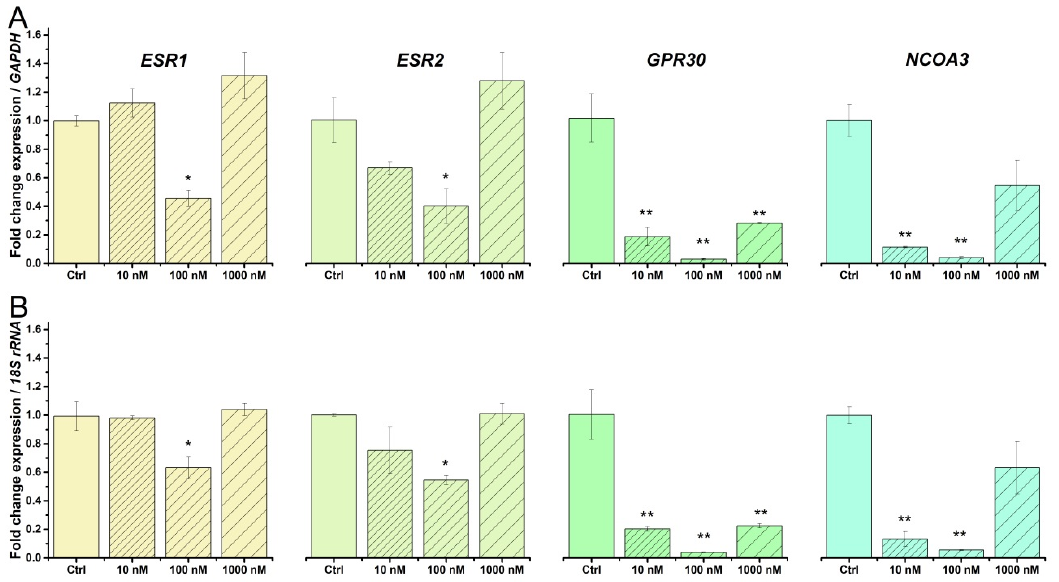
Figure 4. Effect of beta ‐ estradiol treatment (10, 100, and 1000 nM) on the mRNA levels encoding the estrogen receptors and nuclear receptor co ‐ activator in human myometrial TCs from pregnant uterine samples. Fold ‐ change for each receptor upon treatment with beta ‐ estradiol, where the non ‐ treated samples were considered as calibrator. The data were normalized against GAPDH ( A ) and 18S rRNA ( B ) and were plotted as mean ± SD ( N = 3). Statistical significance is indicated with asterisks (* 0.01 < p < 0.05; ** 0.001 < p < 0.01).